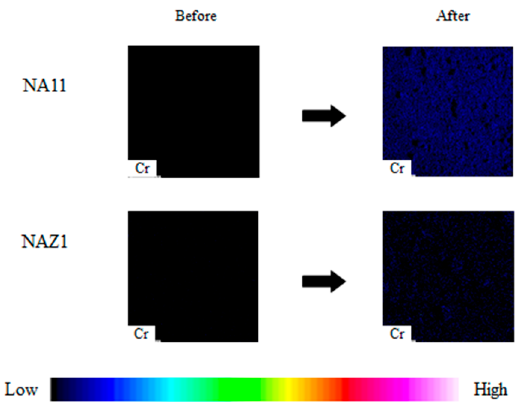
Figure 3. Elemental distribution of Cr(VI) onto NA11 and NAZ1 surface before and after adsorp- tion.